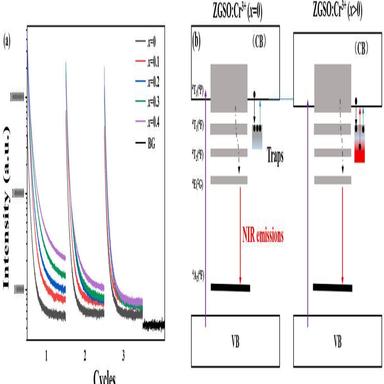
(a) NIR-persistent luminescence decay curve of ZGSO:Cr3+ (x = 0-0.4) heating at 130 ◦C for three rounds. (b) Schematic illustration of NIR-persistent luminescence mechanism before and after heat processing, with red area representing the deep trap and the gray area representing the shallow trap. (For interpretation of the references to color in this figure legend, the reader is referred to the Web version of this article.)